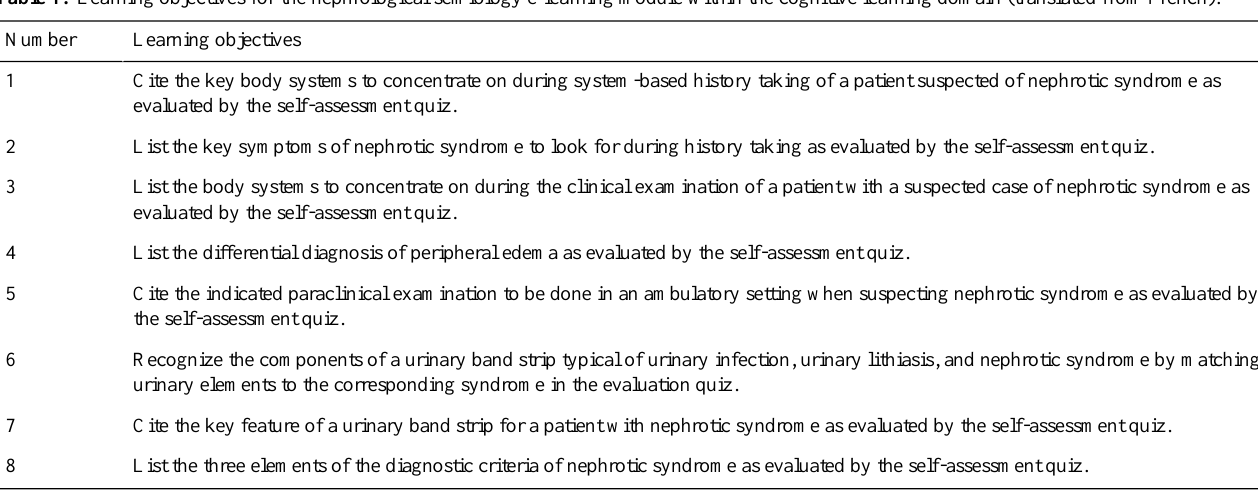
Table 1. Learning objectives for the nephrological semiology e-learning module within the cognitive learning domain (translated from French). Learning objectivesNumber